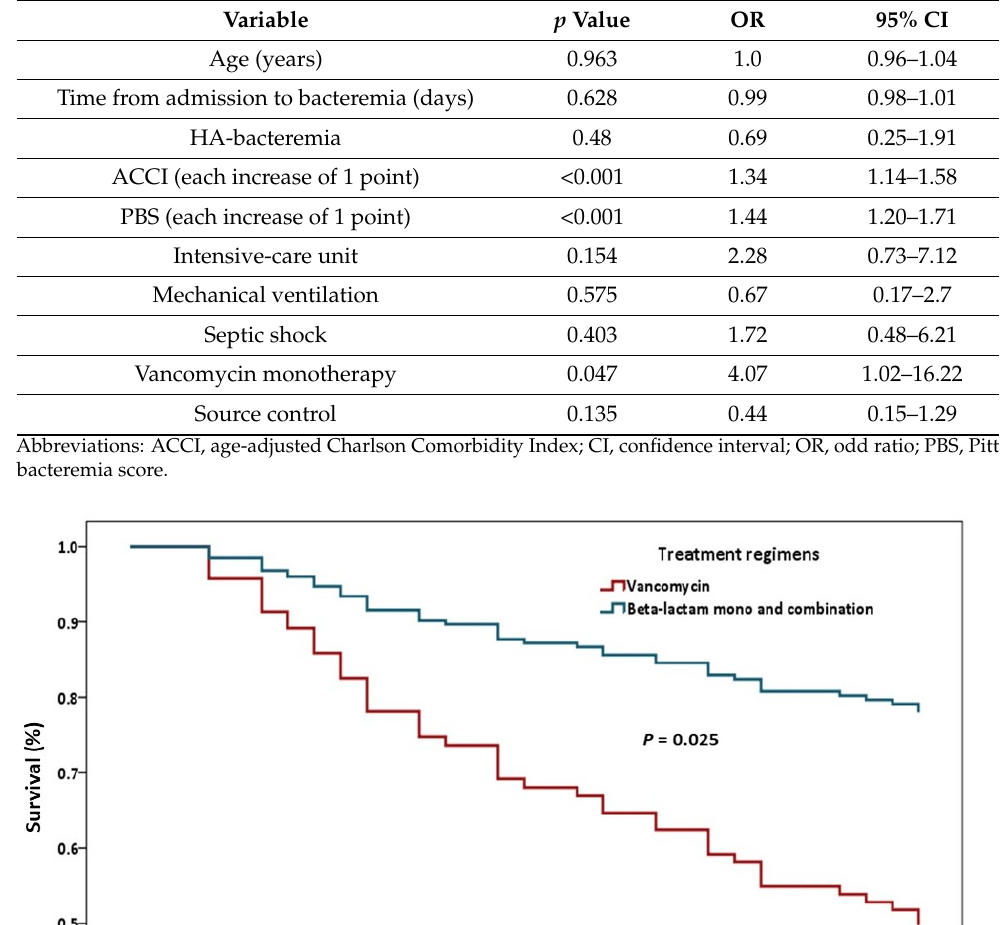
Table 4. Factors associated with all-cause 30-day mortality on multivariate logistic regression analyses.